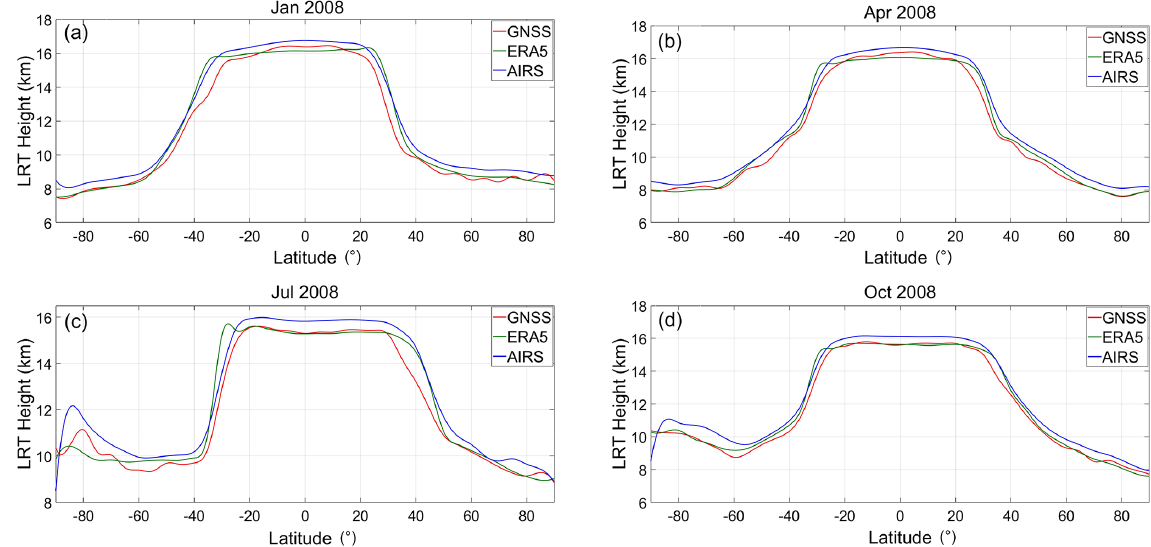
Figure 5. Monthly zonal average LRT height from GNSS, ERA5, and